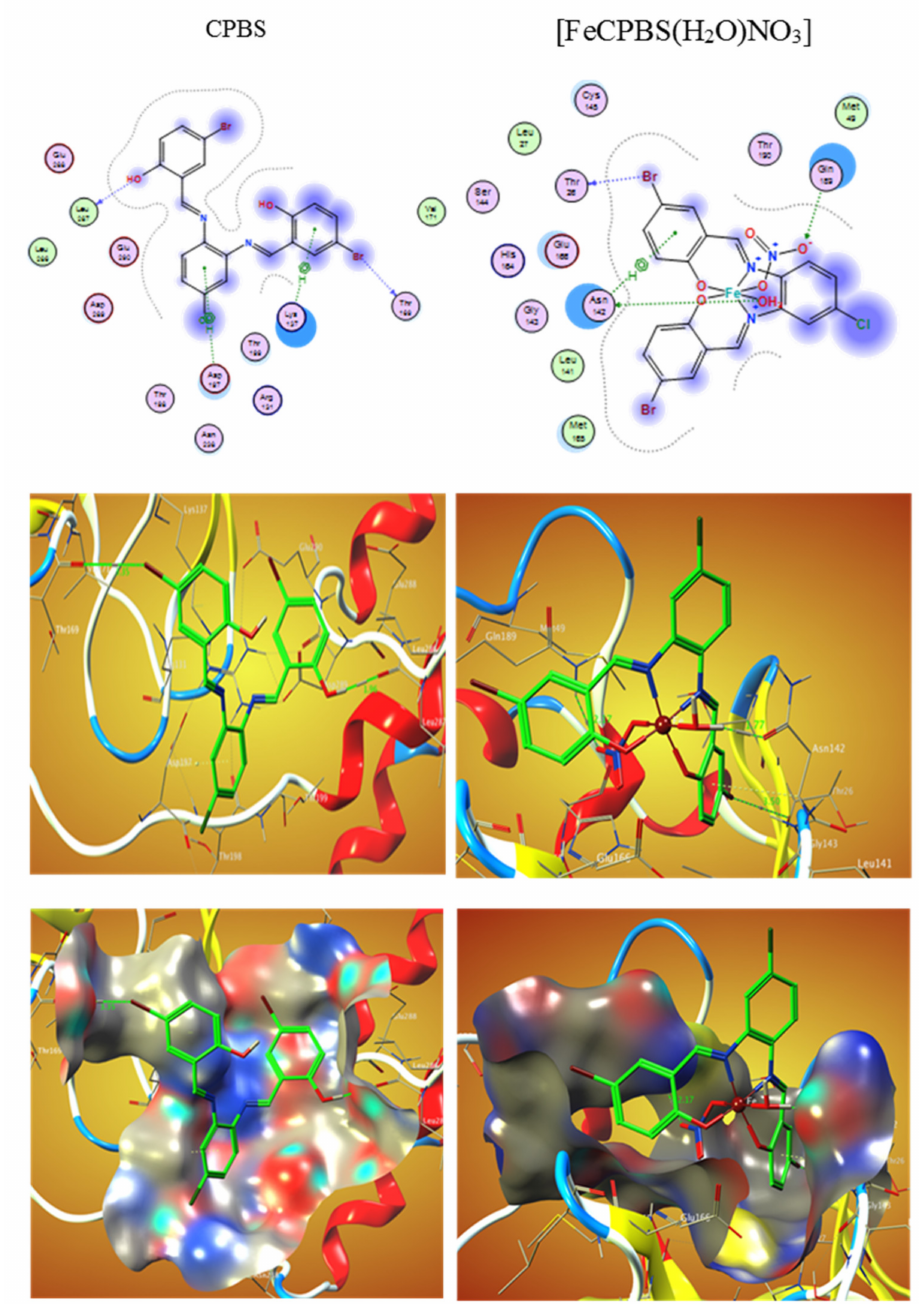
Figure 4. 2D and 3D graphs illustrating the interaction of CPBS and (FeCPBS (H 2 O)NO 3 ) with the active site of the viral protein receptor (PDB ID: 6lu7). Hydrophobic interactions with amino acid residues are depicted by dotted